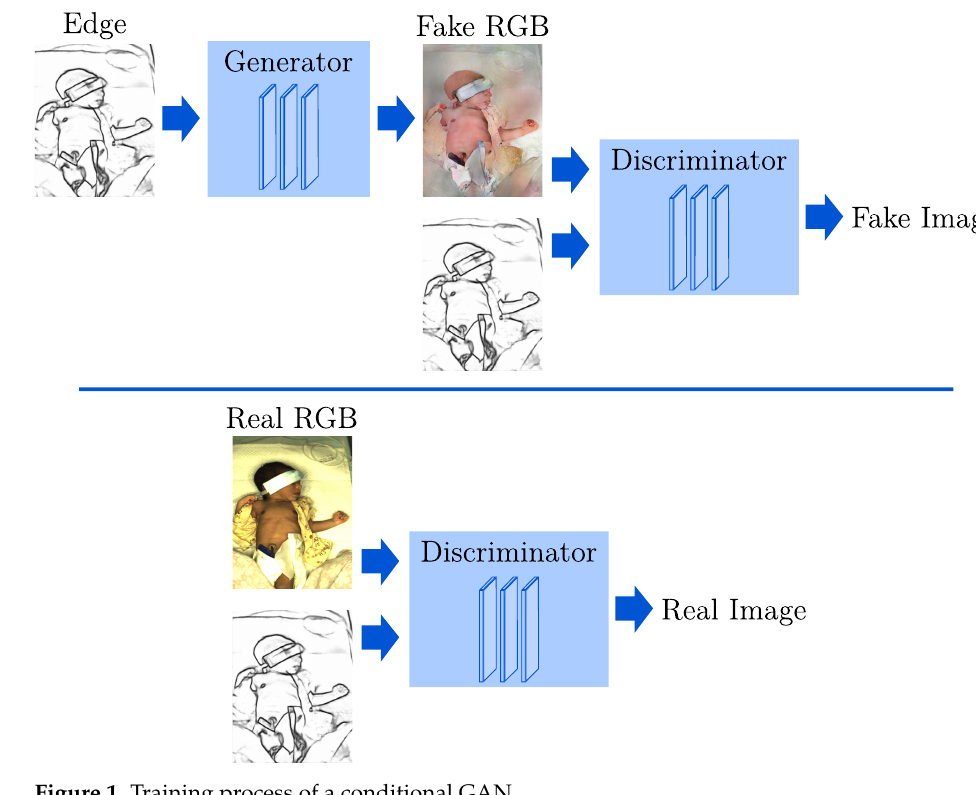
Figure 1. Training process of a conditional